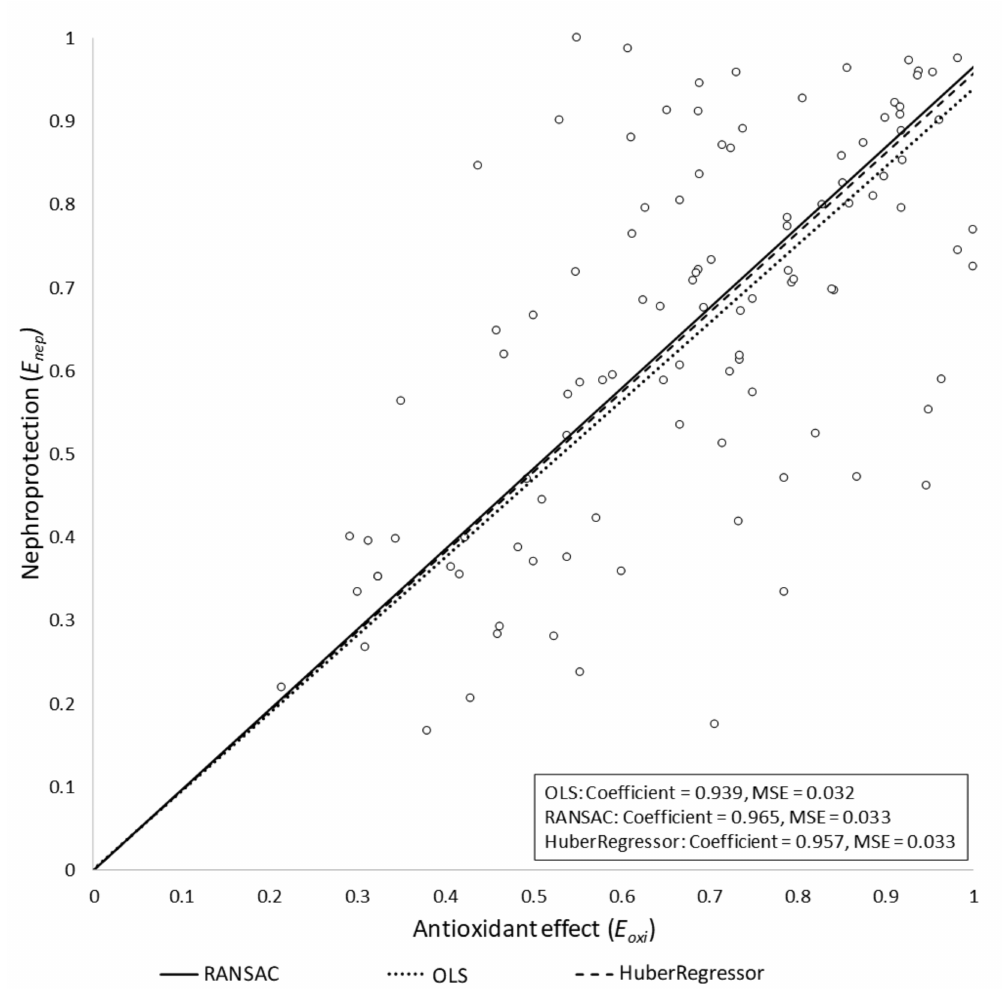
Figure 2. Regression results for the three tested models. The nephroprotection index ( E nep ) is represented versus the antioxidant index ( E oxi ) for the OLS, Huber regression, and RANSAC regression models, all of them yielding similar results. The RANSAC model provided the most robust fit, as it empirically ignored some outlier points, giving them a zero weight in the final adjustment. MSE, mean squared